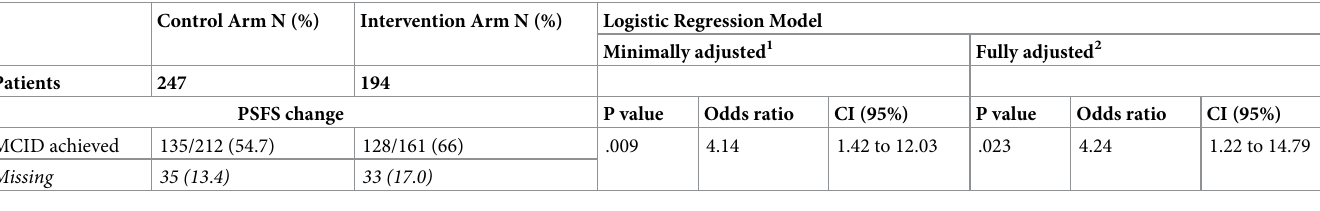
Table 4. Summary of primary outcome measure with adjusted and unadjusted intervention